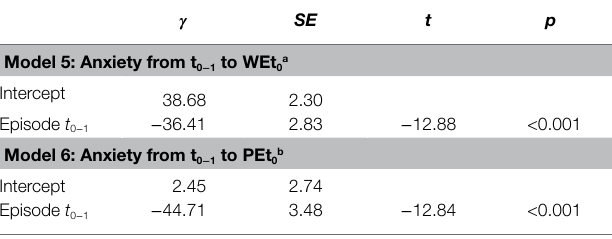
γ SE t p to WEt 0a − 1